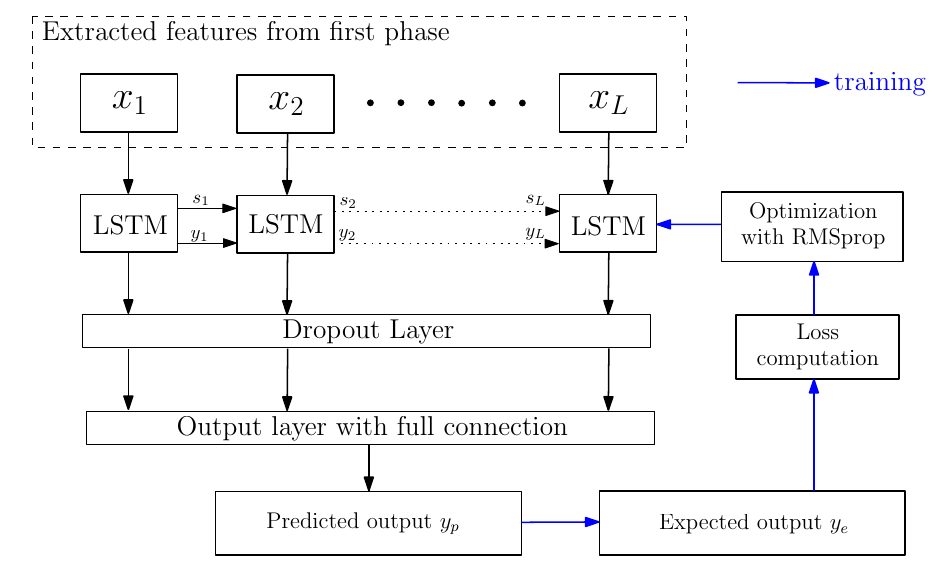
Figure 3. The training process of the LSTM model.